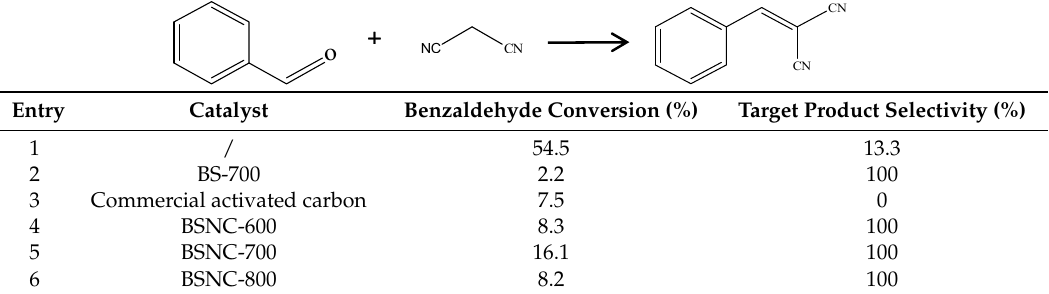
Table 1. Knoevenagel condensation between benzaldehyde and malononitrile in the presence of various catalysts.